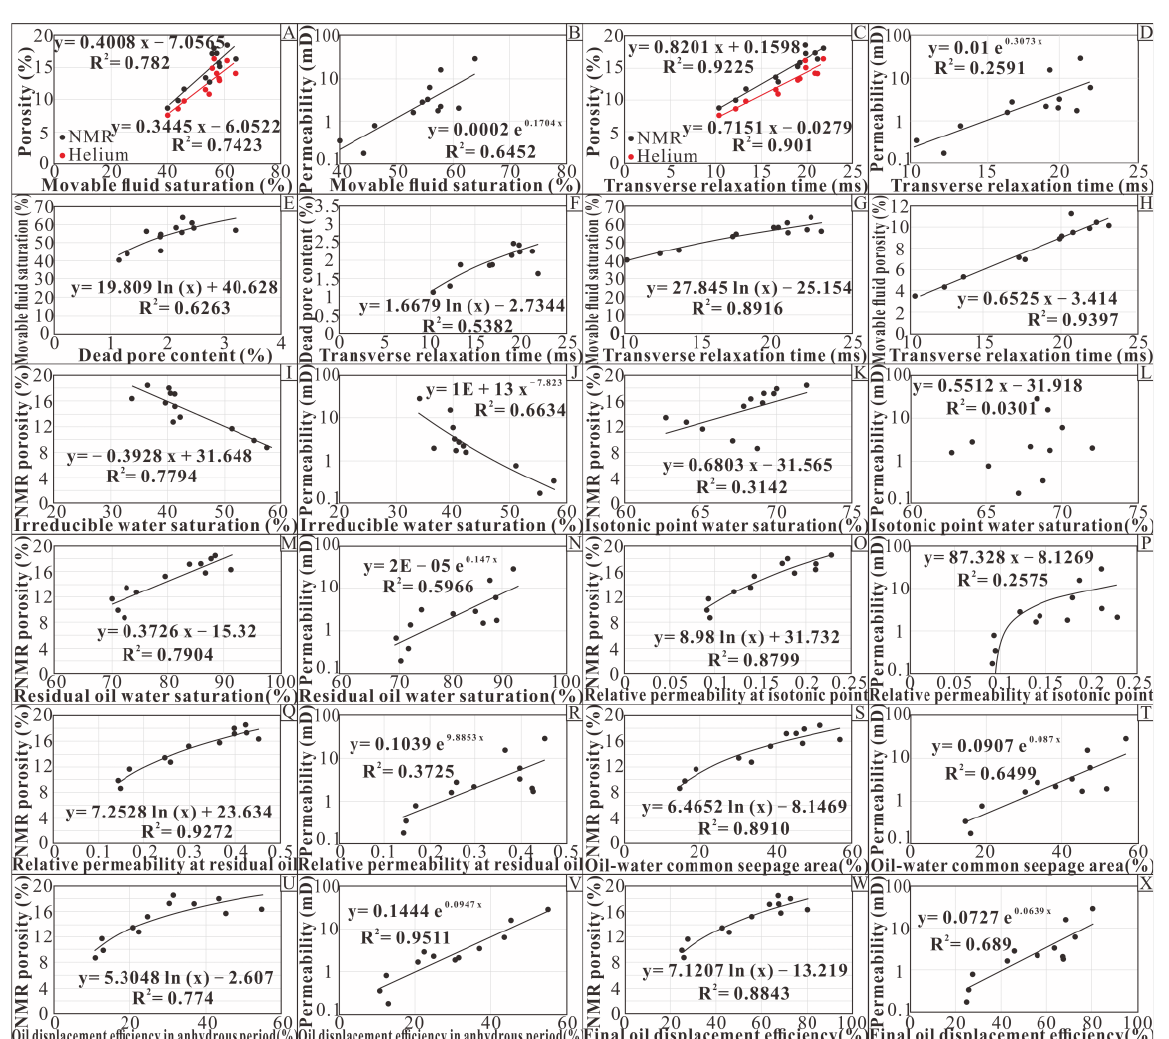
Figure 18. Effects of fluid flowability, two-phase seepage, and water-flooding parameters on physical properties. ( A , B ) Correlation between movable fluid saturation and physical properties. ( C , D ) Correlation between T 2 and physical properties. ( E , F ) Correlation between dead pore content and movable fluid saturation. ( G , H ) Correlation between T 2 and movable fluid saturation. ( I , J ) Correlation between irreducible water saturation and physical properties. ( K , L ) Correlation between isotonic point water saturation and physical properties. ( M , N ) Correlation between residual oil water saturation and physical properties. ( O , P ) Correlation between relative permeability at isotonic point and physical properties. ( Q , R ) Correlation between relative permeability at residual oil and physical properties. ( S , T ) Correlation between Oil-water common seepage area and physical properties. ( U , V ) Correlation between oil displacement efficiency in anhydrous period and physical properties. ( W , X ) Correlation between final oil displacement efficiency and physical properties.